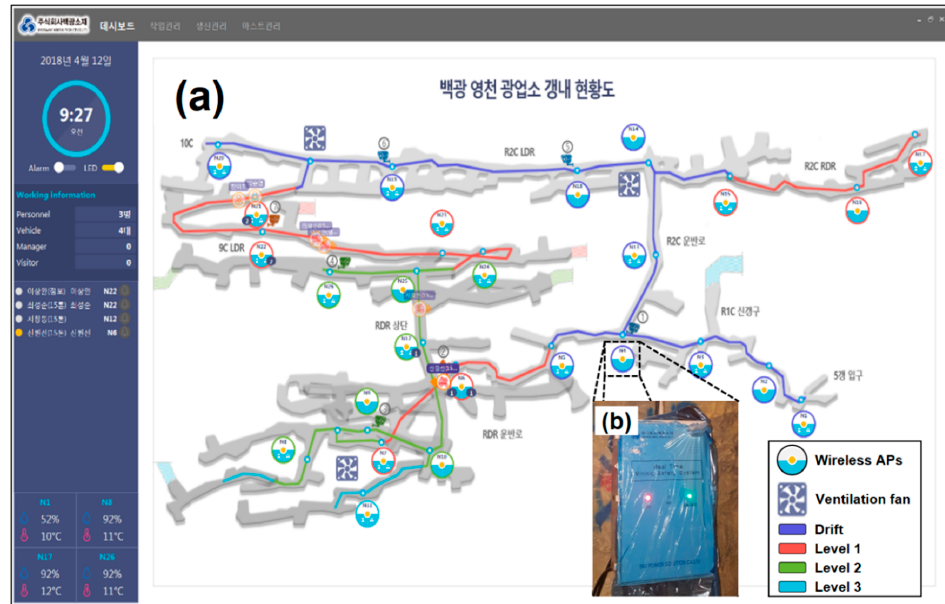
Figure 2. Components of the mine safety management system installed in the study area: ( a ) main dashboard showing the location of dump trucks and loaders; ( b ) wireless APs.